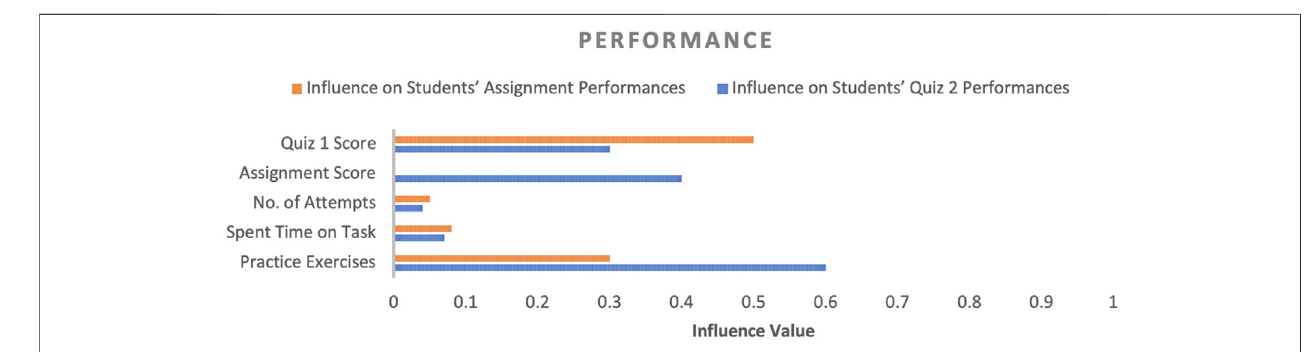
FIGURE 5 | In fl uence of performance-related factors on students ’ performance.